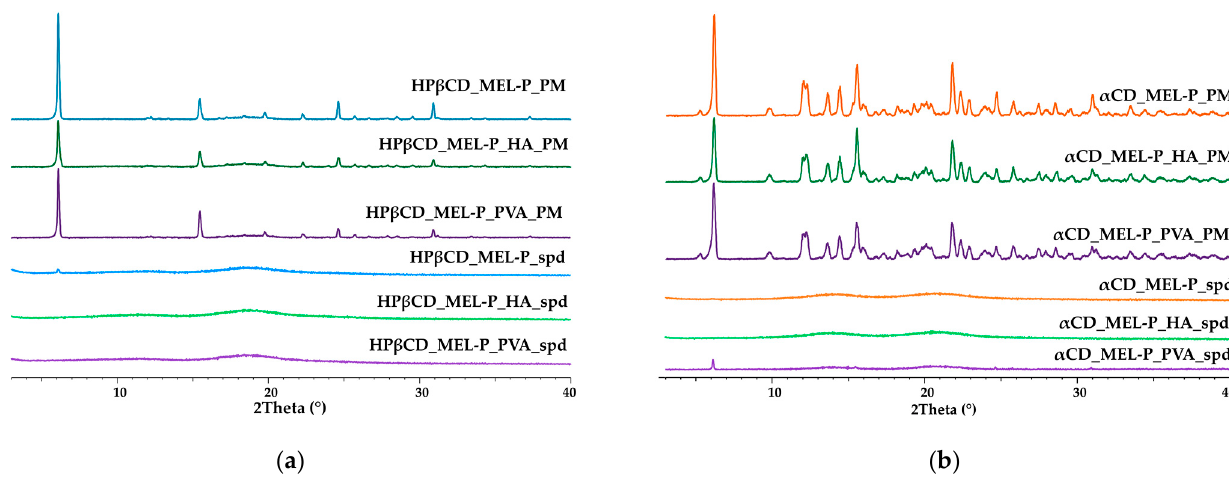
Figure 5. XRPD diffractograms of: ( a ) the HP β CD-containing and ( b ) the α CD-containing PMs and spray dried samples.